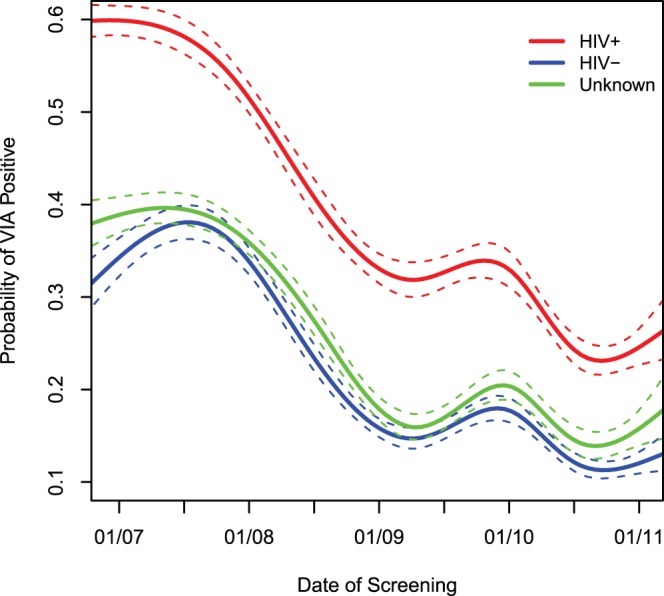
Probability of being detected as VIA positive stratified by HIV-serostatus among women utilizing services of the Cervical Cancer Prevention Program in Zambia (CCPPZ).